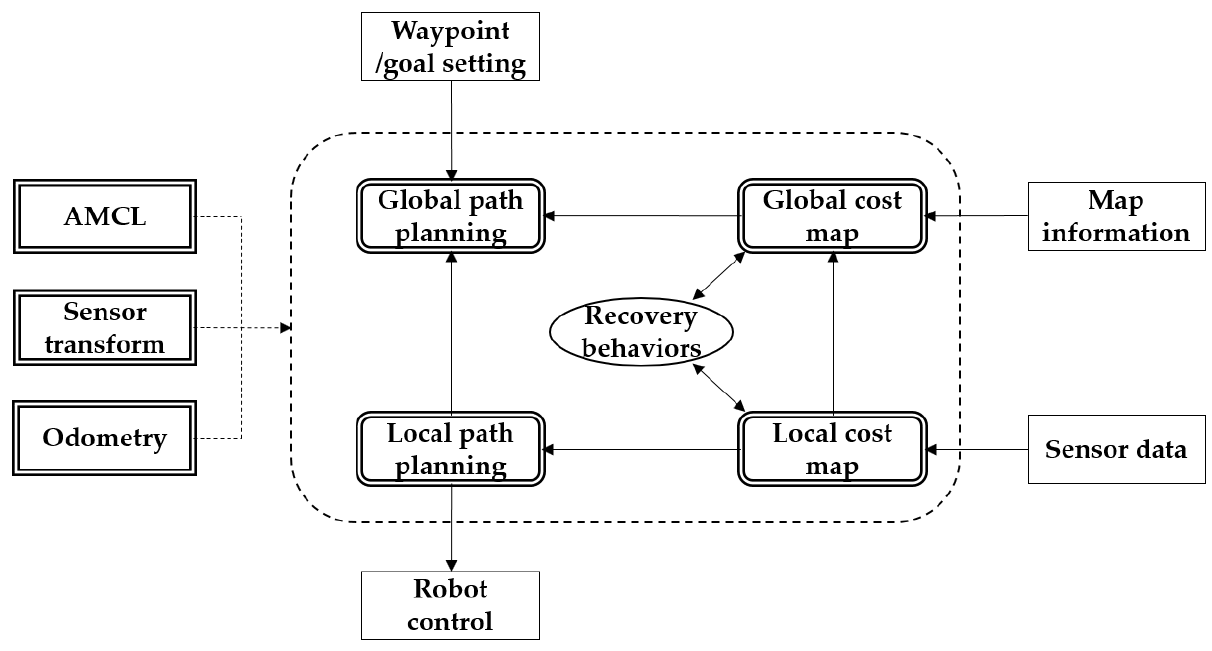
Figure 4. System architecture of the ROS-based autonomous navigation system used in this study.